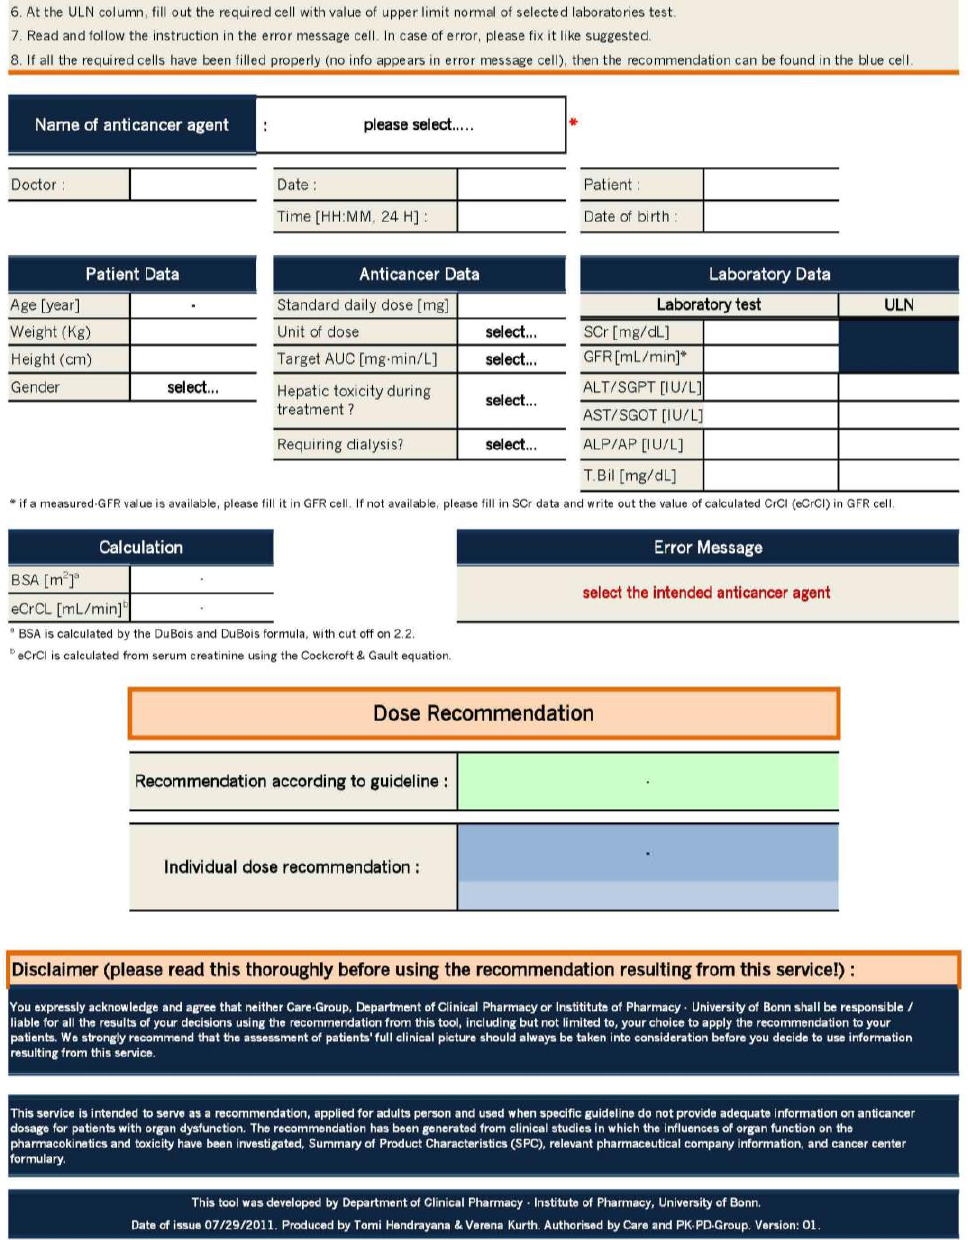
Figure 3. Easy-to-use Excel tool.